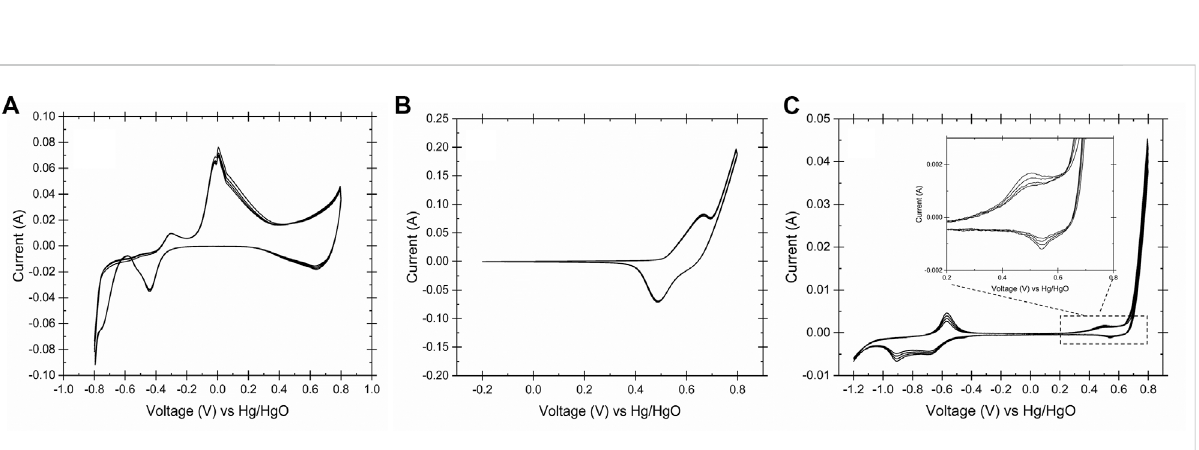
FIGURE 3 Cyclicvoltammogramoftheworkingelectrodesobtainedin0.2 MNaOH,25 ° Candscanrate50 mV s − 1 , (A) copper, (B) Niand (C) stainlesssteel 316. The CVs showed the identical oxidation/reduction peaks of copper, nickel and iron on the surface of working electrodes.